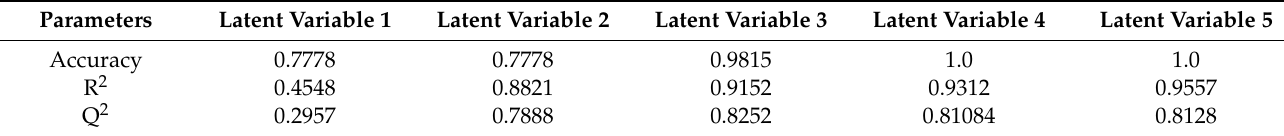
Table 2. Statistical parameters for the evaluation of the PLS-DA model according to the number of components for the classification